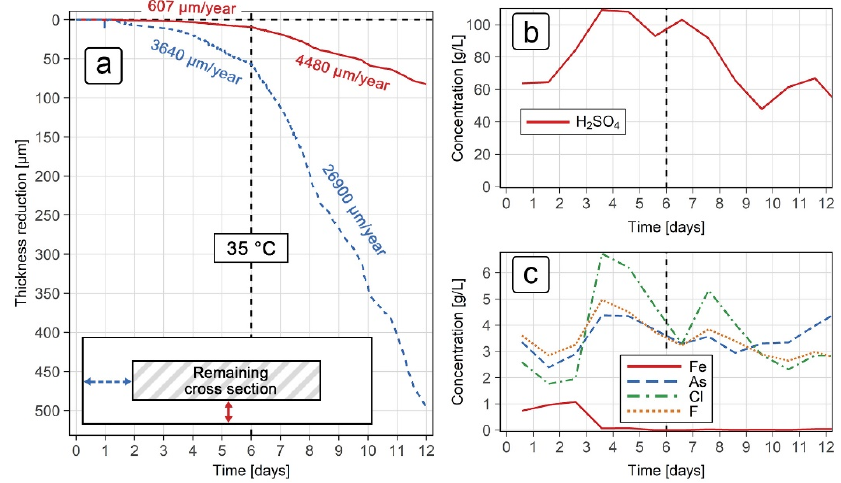
Figure 10. Exposure of grade 316L ER sensor under industrial conditions: ( a ) thickness reduction results; ( b ) concentration of sulfuric acid; ( c ) concentration of the various ions.